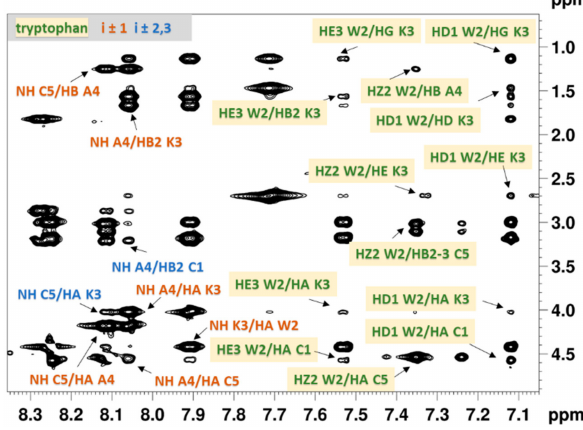
Figure 2. Expanded region of the ROESY spectrum of Ac-c(CWKAC)-NH 2 measured in DMSO- d 6 at 298 K with the mixing time of 150 ms. Sequential (i ± 1) and medium range (i ± 2,3) ROE peaks are labelled by orangeand blue, respectively. Interresidual ROEs of Trp are highlighted by yellow